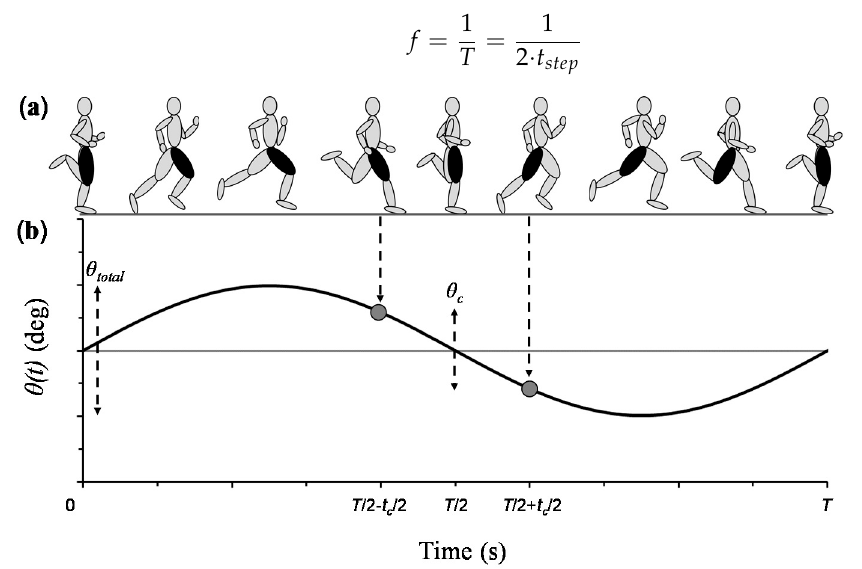
Figure 1. Leg angular motion during the gait cycle. ( a ) Simplified illustration of harmonic oscillatory thigh motion that assumes symmetrical peak thigh flexion and extension values. ( b ) Thigh angular position θ (t) during the gait cycle. Thigh angular kinematics as a function of time are determined by the parameters of frequency ( f = 1/ T , where T is the period of the cycle) and θ total , which is the total thigh range of motion from peak extension through peak flexion. The total excursion angle during contact ( θ c ) occurs in the contact time ( t c ) between t = T /2 − t c /2 and t = T /2 + t c /2.